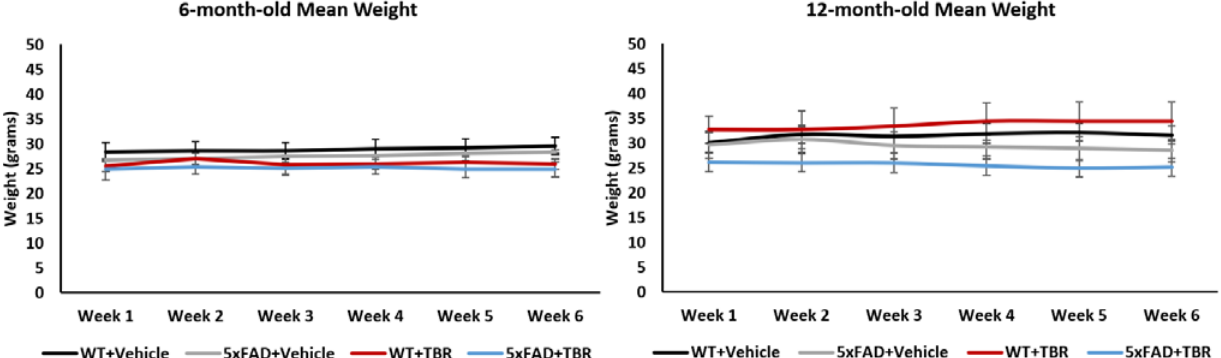
Figure 3. Mean weight. No between- or within-group differences in body weight were observed over the course of the